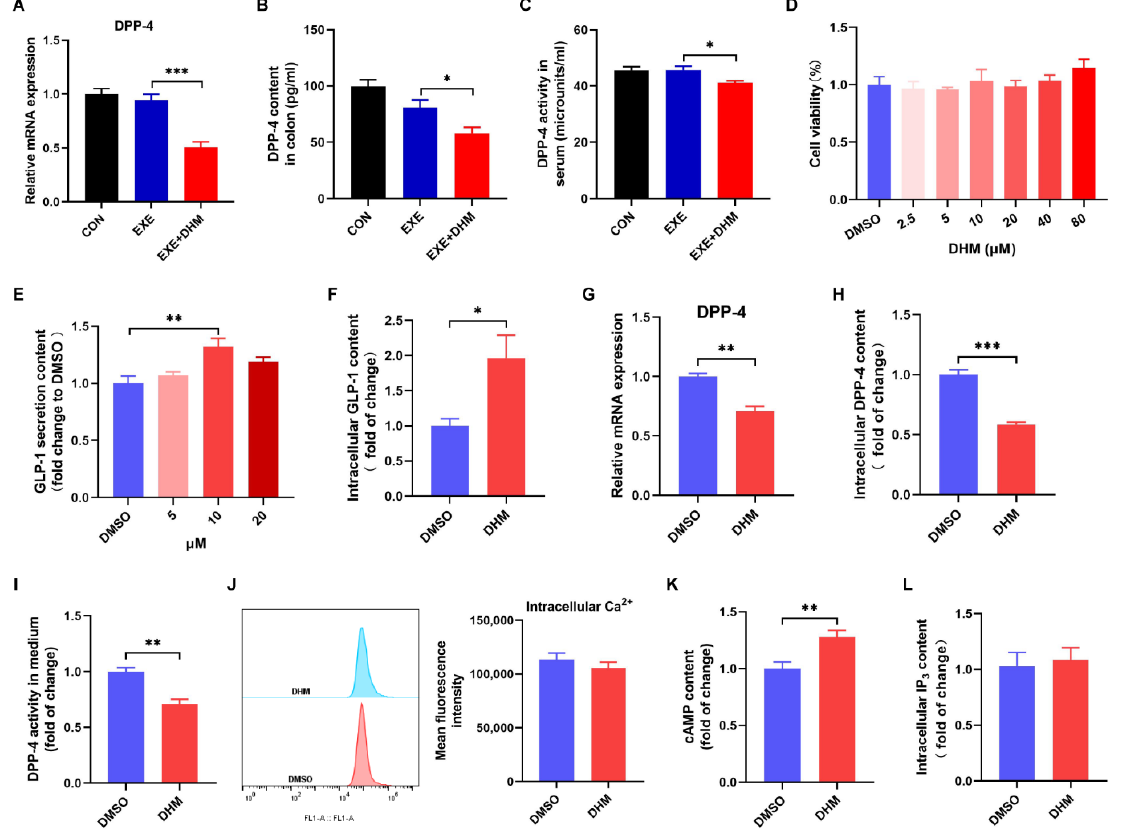
Figure 8. Dihydromyricetin stimulates GLP ‐ 1 secretion and inhibits DPP ‐ 4 in vivo and in vitro. ( A ) qPCR analysis of the expression of DPP ‐ 4 in the colon. ( B ) DPP ‐ 4 content was measured using an ELISA kit in the colon. ( C ) DPP ‐ 4 activity in serum. ( D ) Cell viability of GLUTag cells treated with DHM (0–80 μ M). ( E ) GLP ‐ 1 secretion from GLUTag cells with DHM (5 μ M, 10 μ M, 20 μ M) stimu ‐ lation. ( F ) GLP ‐ 1 content in cell lysates was measured using an ELISA kit. ( G ) qPCR analysis of the gene expression of DPP ‐ 4 in GLUTag cells. ( H ) DPP ‐ 4 content in cell lysates was measured using an ELISA kit. ( I ) DPP ‐ 4 activity in cell culture medium. ( J ) Mean fluorescence intensity of intracellular Ca 2+ . ( K ) Luminescence indicated cAMP concentrations. ( L ) IP 3 content in cell lysates was measured using an ELISA kit. Data are expressed as the mean ± SEM. One ‐ way ANOVA: ( A – E ). Unpaired t ‐ test: ( F – L ). * p < 0.05, ** p < 0.01, and *** p < 0.001. 4. Discussion Scientific studies have confirmed that exercise has a variety of health benefits, includ ‐ ing physiological, cardiovascular, and mental health benefits. Numerous studies have shown that single bouts of exercise reduced orexigenic hormone acylated ghrelin, in ‐ creased anorexigenic signals GLP ‐ 1 and PYY, and subsequently regulated appetite [7,8]. Moreover, chronic exercise has been reported to elevate GLP ‐ 1 secretion [25]. These are critical reasons for exercising to reduce fat mass and control body weight. Although dec ‐ ades of research have been done, the underlying mechanisms through which exercise